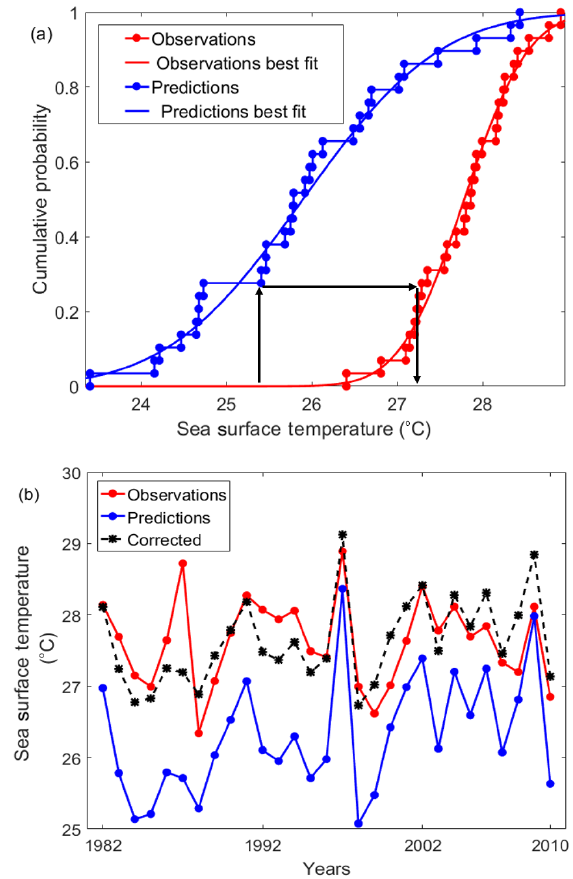
Figure 6. (a) Quantile mapping of predicted and observed NOAA NCEP CFSv2 Niño 3.4 sea surface temperature (SST) data; (b) ob- served, predicted, and statistically corrected NOAA NCEP CFSv2 Niño 3.4 SST